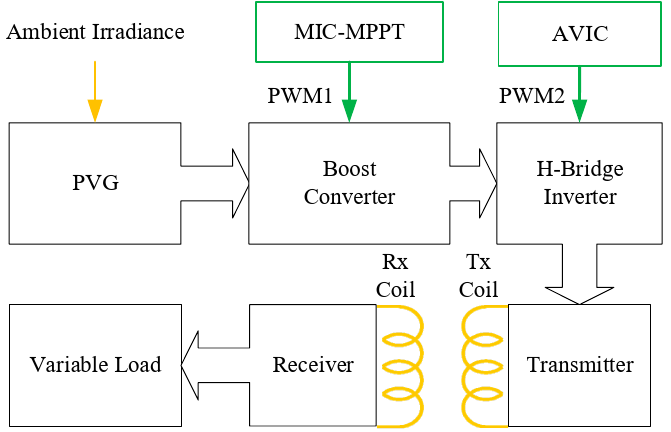
Figure 2. Block diagram of the proposed wireless power transmission system (WPTS) with its Figure2. controllers.